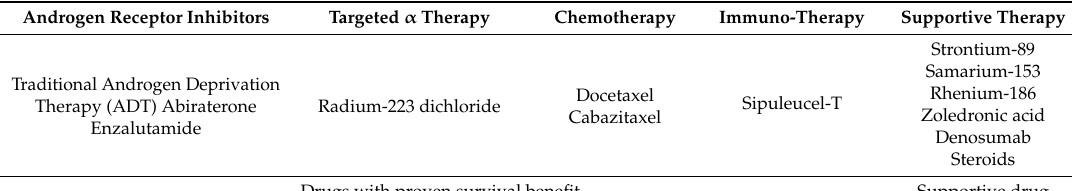
Table 2. Class of drugs currently available for patients with metastatic prostate cancer.